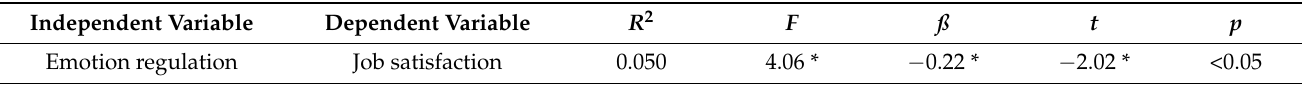
Table 5. Regression results: emotion regulation and job satisfaction levels in family firms. Independent